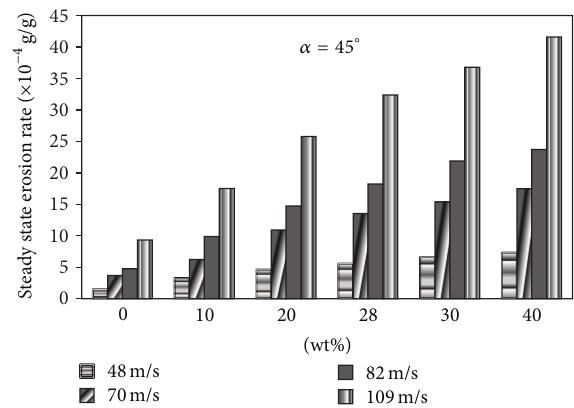
Figure 4: Variations of erosion rates of PVA/DPL composites with different fiber loadings.